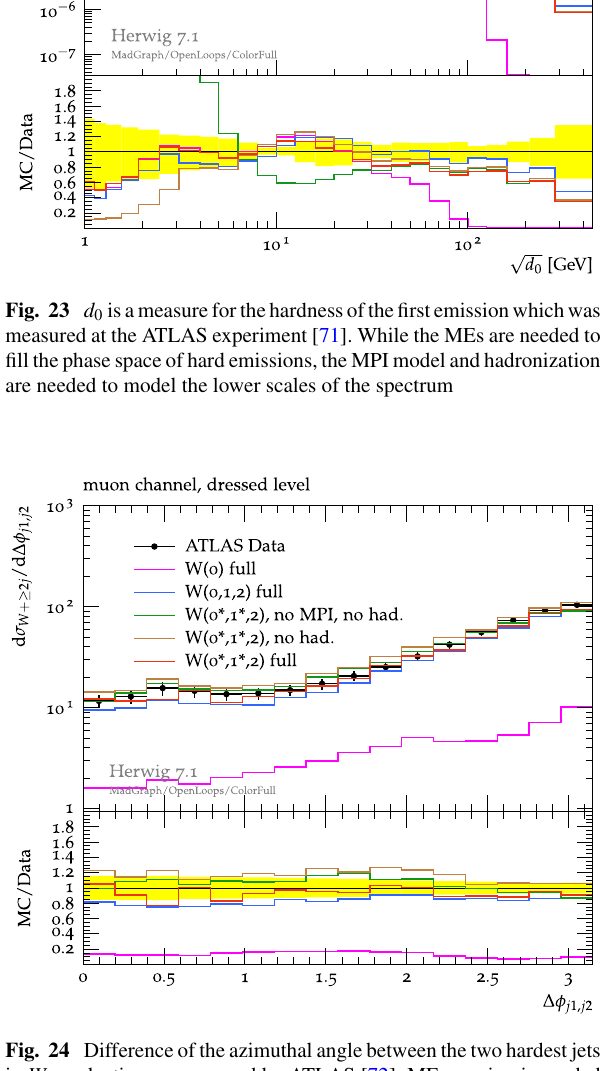
behaviour is important is the azimuthal difference Δφ j 1 , j 2 between the two hardest jets. In Fig. 24 our simulation of this is compared to data measured by the ATLAS collaboration [72]. Once again, we find the best simulation for W ( 0 ∗ , 1 ∗ , 2 ) with inclusion of all non-perturbative